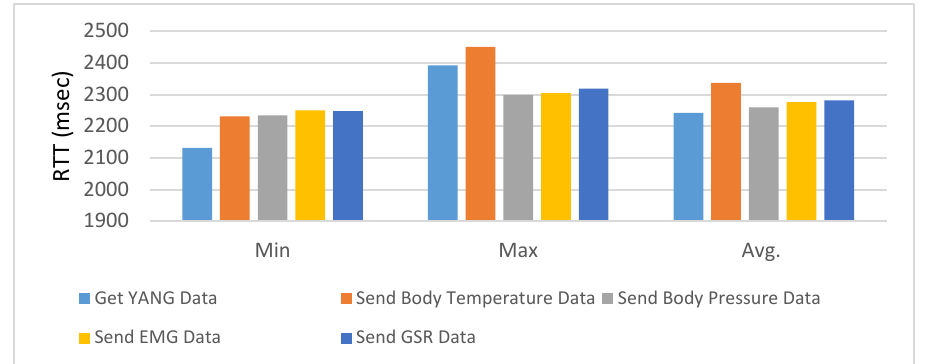
Figure 10. Comparison of RTT for each IoTivity communication of activities.